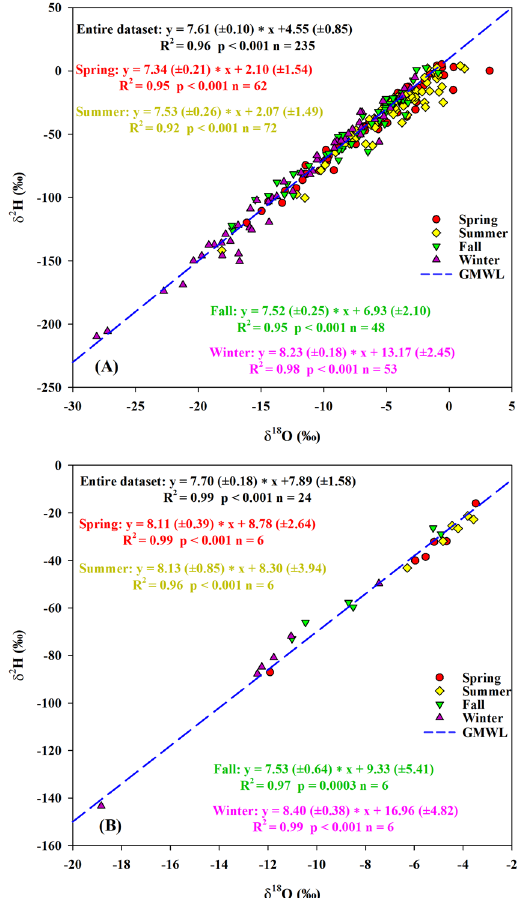
Figure 4. Local meteoric water lines from δ 2 H and δ 18 O in daily ( A ) and monthly ( B ) precipitation within different seasons between June 2014 and May